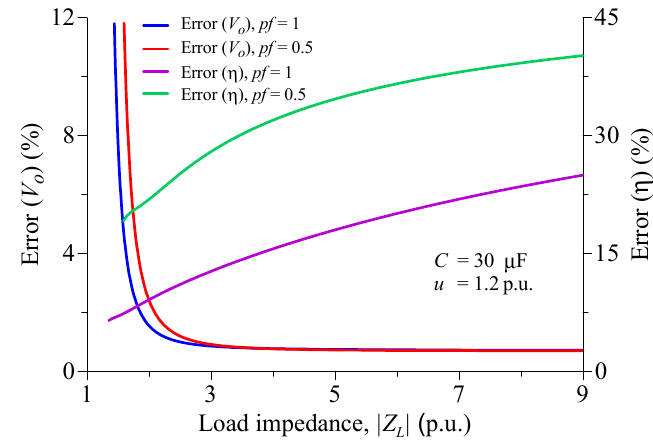
Figure 18. Error variation of terminal voltage V o and efficiency η versus load impedance | Z L |.